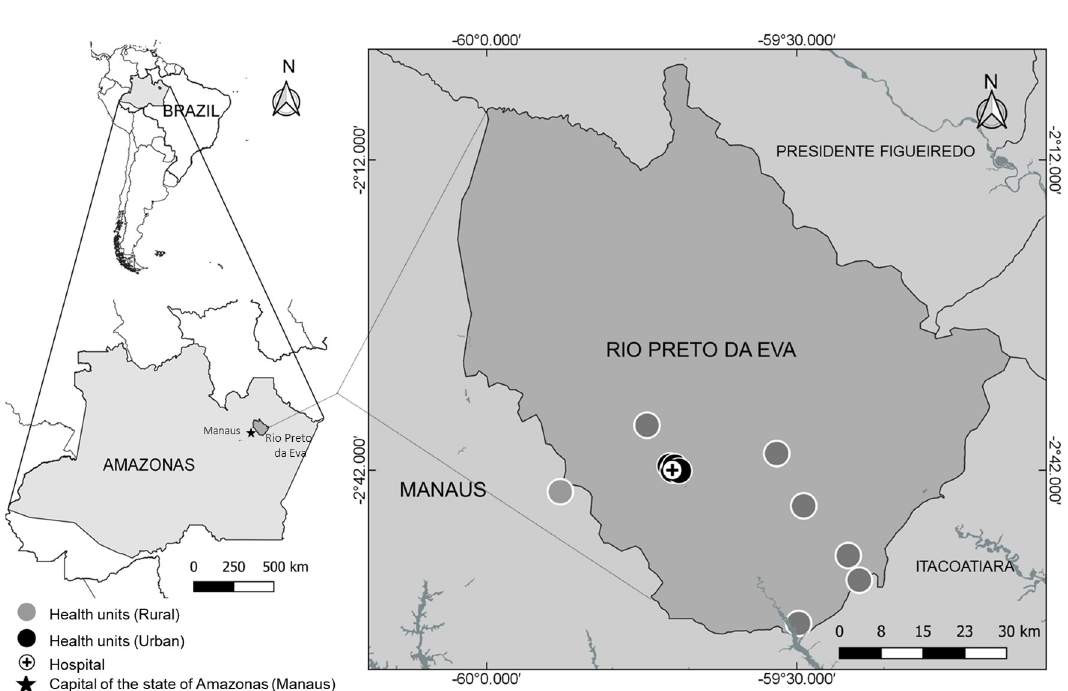
Fig 1. Study location and malaria treatment units (MTU). Rio Preto da Eva is located 78 km from Manaus, capital of the State of Amazonas, Western Brazilian Amazon. The test was implemented in 5 urban (including the local hospital, black sign and black circle, respectively) and 7 rural health posts (filled grey circles). This map was created using the base from the Brazilian Institute of Geography and Statistics (https://portaldemapas.ibge.gov.br/portal.php#homepage).